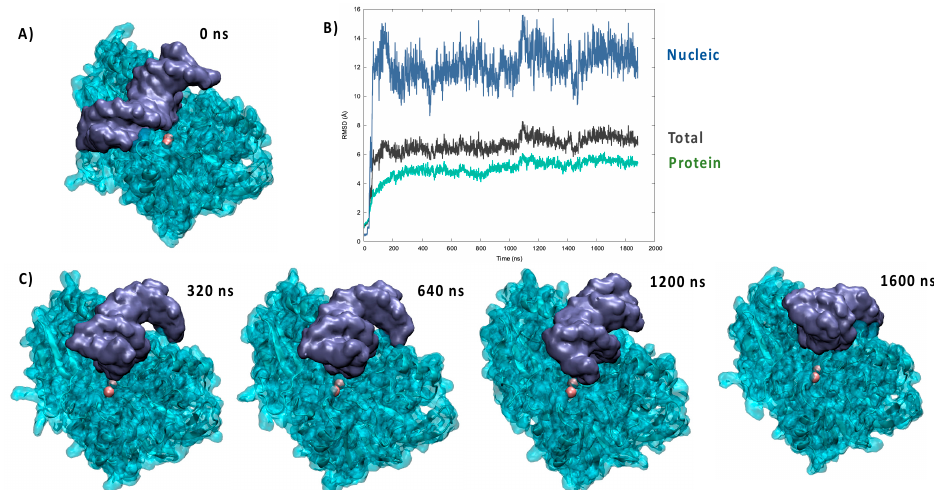
Figure 1. ( A ) Most favorable pose resulting from the docking of the crystal structure of Artemis with a DNA double strand. ( B ) Time evolution of the RMSD for the MD simulation of the Artemis/DNA complex. ( C ) Representative snapshots extracted at different time frames of the MD simulation.